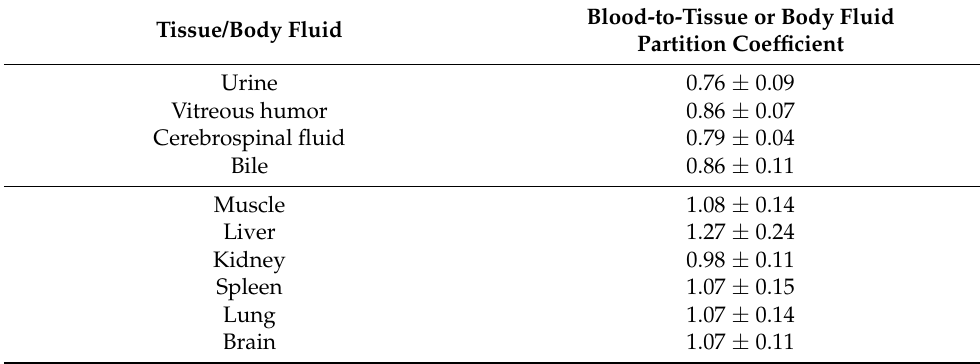
Table 3. The blood-to-tissue or body fluid partition coefficient for methanol detected in fatal methanol poisoning victims (n = 13). The results are presented as mean ±